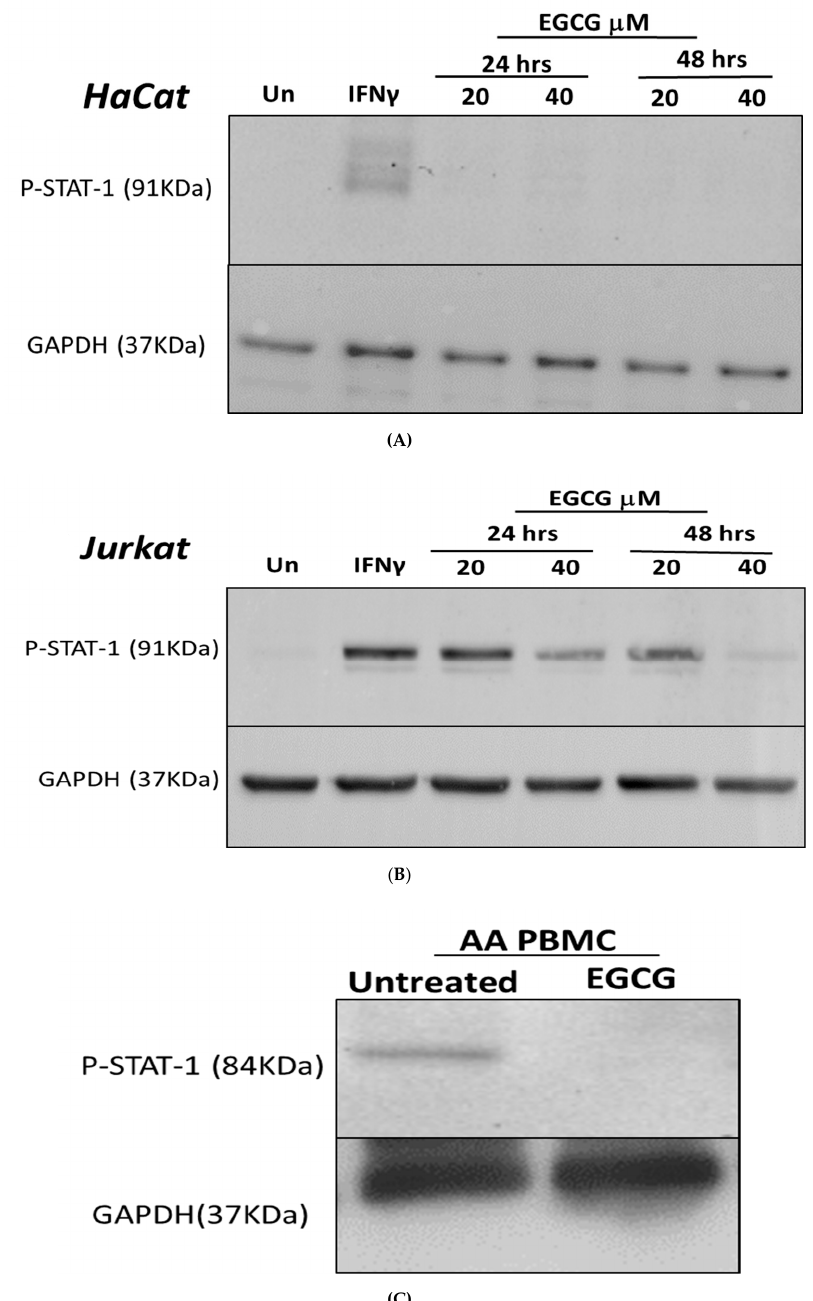
Figure 2. The effect of Epigallocatechin-3-gallate (EGCG) on P-STAT-1 protein in HaCat ( A ) and Jurkat cells ( B ). STAT-1 phosphorylation was induced by treating the cells with IFN- γ for 48 h. The cells were then treated with 20 and 40 µ m EGCG for 24 or 48 h, with the protein levels determined by Western blotting. ( A ) HaCat cells showed marked inhibition at STAT-1 phosphorylation when treated with 40 µ m for 48 h. ( B ) Jurkat cells respond to EGCG treatment in a dose-dependent manner where 40 µ m dosage showed a more marked reduction in p-STAT-1 protein compared to 20 µ m. A representative immunoblot is shown. ( C ) Peripheral blood mononuclear cells of alopecia areata (AA) patients were treated with 40 µ m EGCG or left untreated. pSTAT1 was shown to be expressed in patients’ samples and declined after treatment with EGCG. n = 3, p < 0.05 was